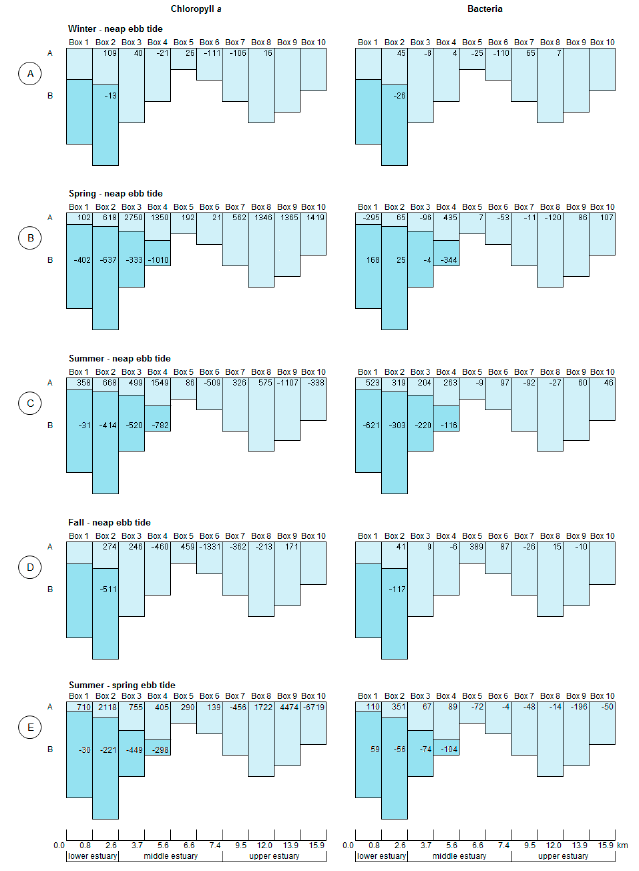
Figure 5. Model box results for chlorophyll a (10 − 3 mg m − 3 h − 1 ) and bacteria (10 9 cells m − 3 h − 1 ), rates of production (positive values) and loss (negative values) for the seasonal neap tides ( A – D ), and the summer spring tide ( E ). A —upper layer corresponding to salinity lower than 18 and B —lower layer corresponding to salinity higher than 18. The vertical axis represents the relative depth of each